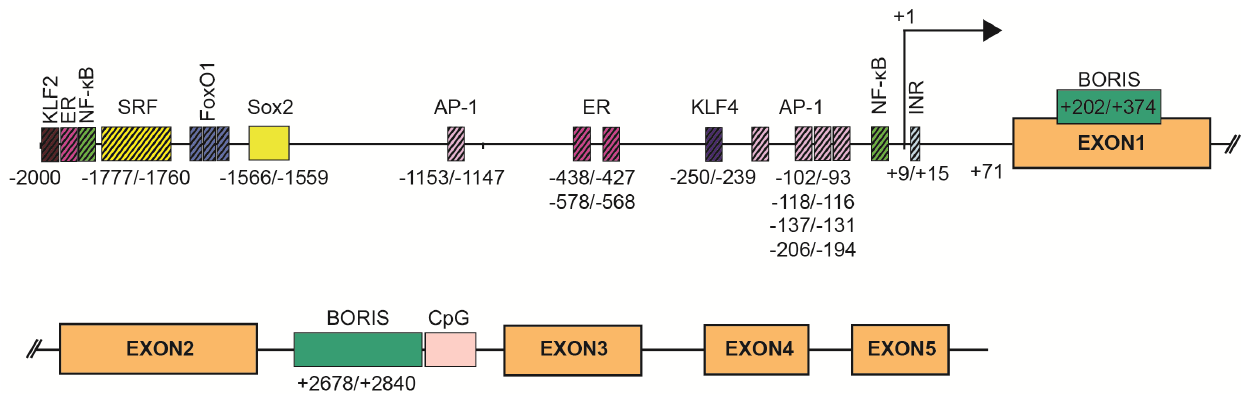
Figure 3. SBSN promoter. Two kilobase pairs upstream of the promoter and downstream sequence of human SBSN with predicted transcription factor binding sites. SOX2 binding site is currently the only validated site [12] together with Brother of the Regulator of Imprinted Sites (BORIS) binding sites [13].